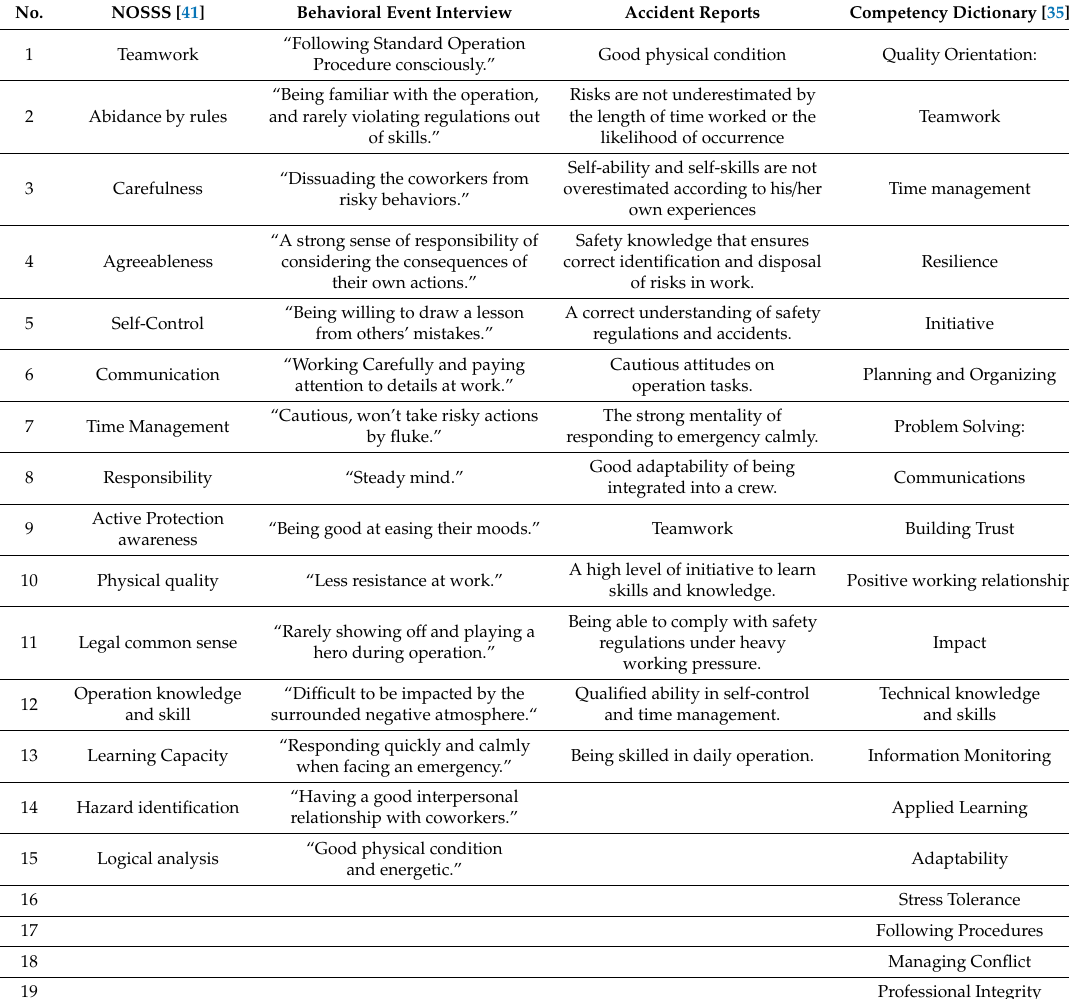
Table 2. Potential items a ff ecting workers’ safety